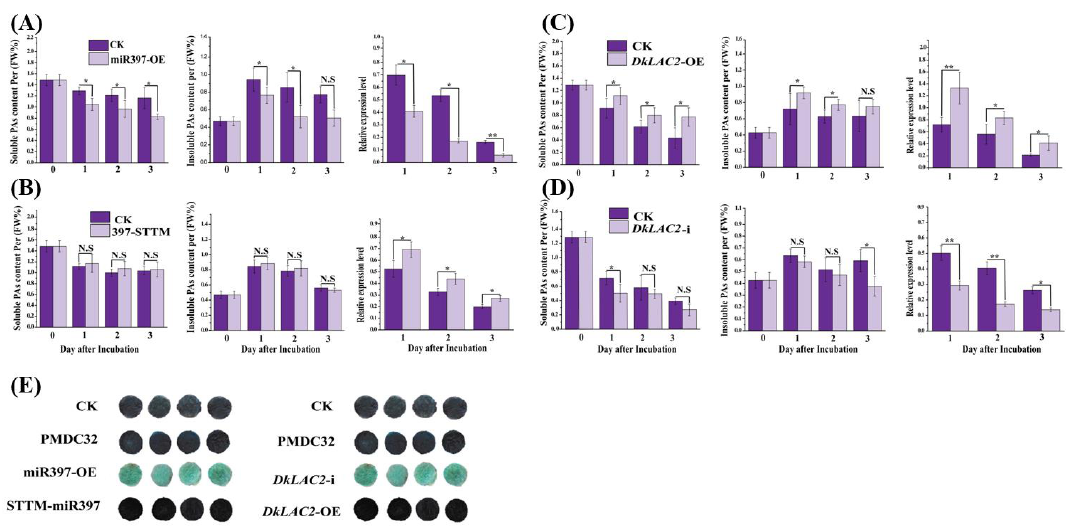
Figure 4. Transient expression of DkmiR397, DkLAC2 in vitro, and DMACA staining technique in ‘ Eshi 1 ’ (C-PCNA) persimmon. Relative expression and PAs concentration by Folin-Ciocalteu after transformation with ( A ) DkmiR397, ( B ) STTM-DkmiR397, ( C ) DkLAC2 -OE, ( D ) DkLAC2 -I, and ( E ) DMACA staining of fruit discs of ‘ Eshi 1 ’ was performed 3 days after infection. CK, blank control; pMDC32, empty vector. Error bars indicate SEs from three biological replicates ( n = 3). Asterisks above the bars indicate va lues determined by Student’s t -test to be significantly different from the control (* p < 0.05, ** p < 0.01); N.S: non-significant.